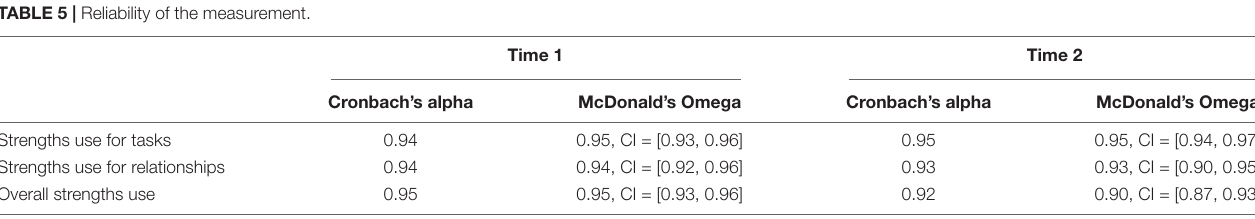
TABLE 5 | Reliability of the